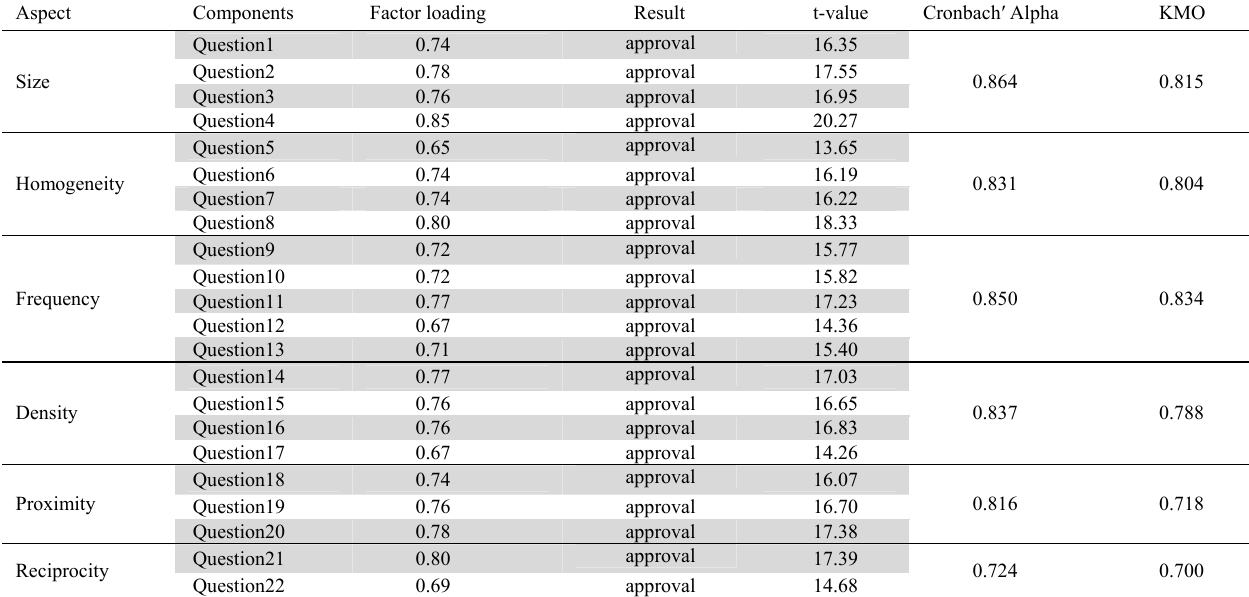
Statistical analysis of research